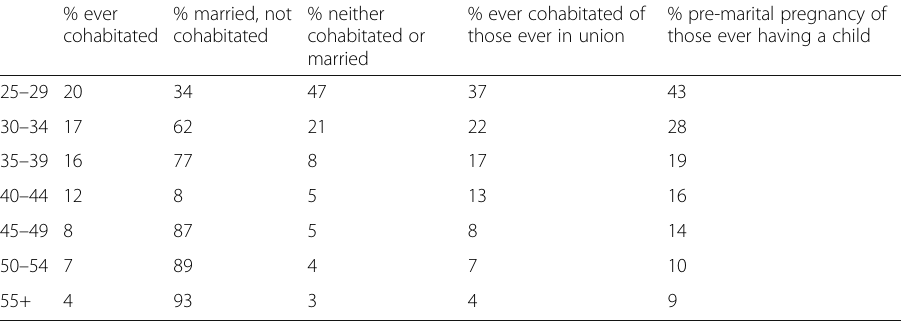
Table 4 Partnership formation and parenthood, Japanese women aged 25 – 69 years in 2004 % ever % married, not % neither % ever cohabitated of cohabitated cohabitated cohabitated or those ever in union married